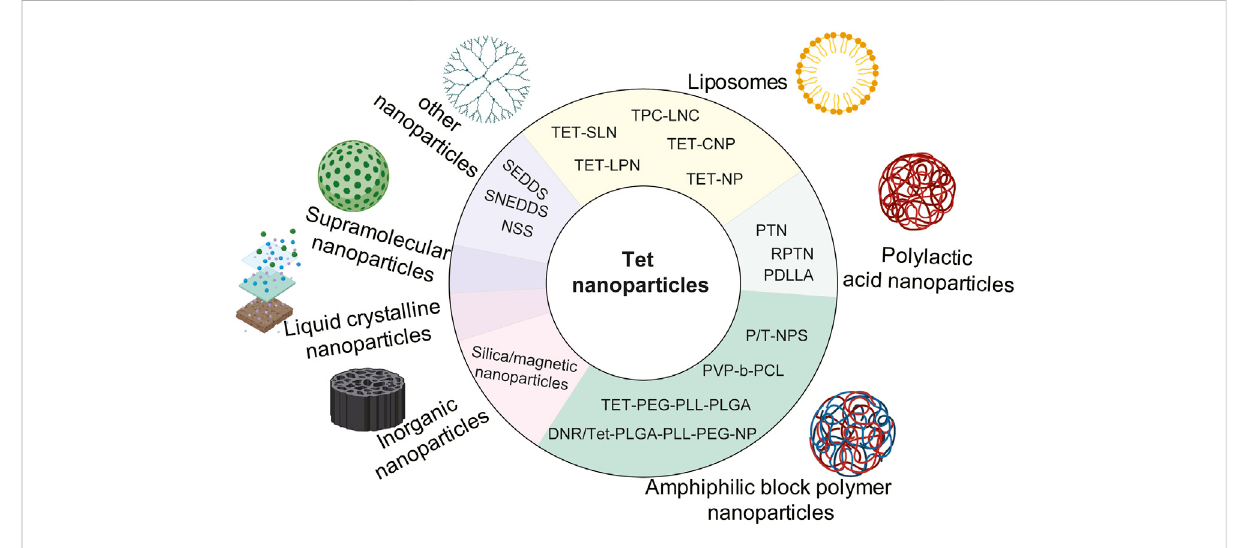
FIGURE 4 Structural modi fi cation of Tet based on